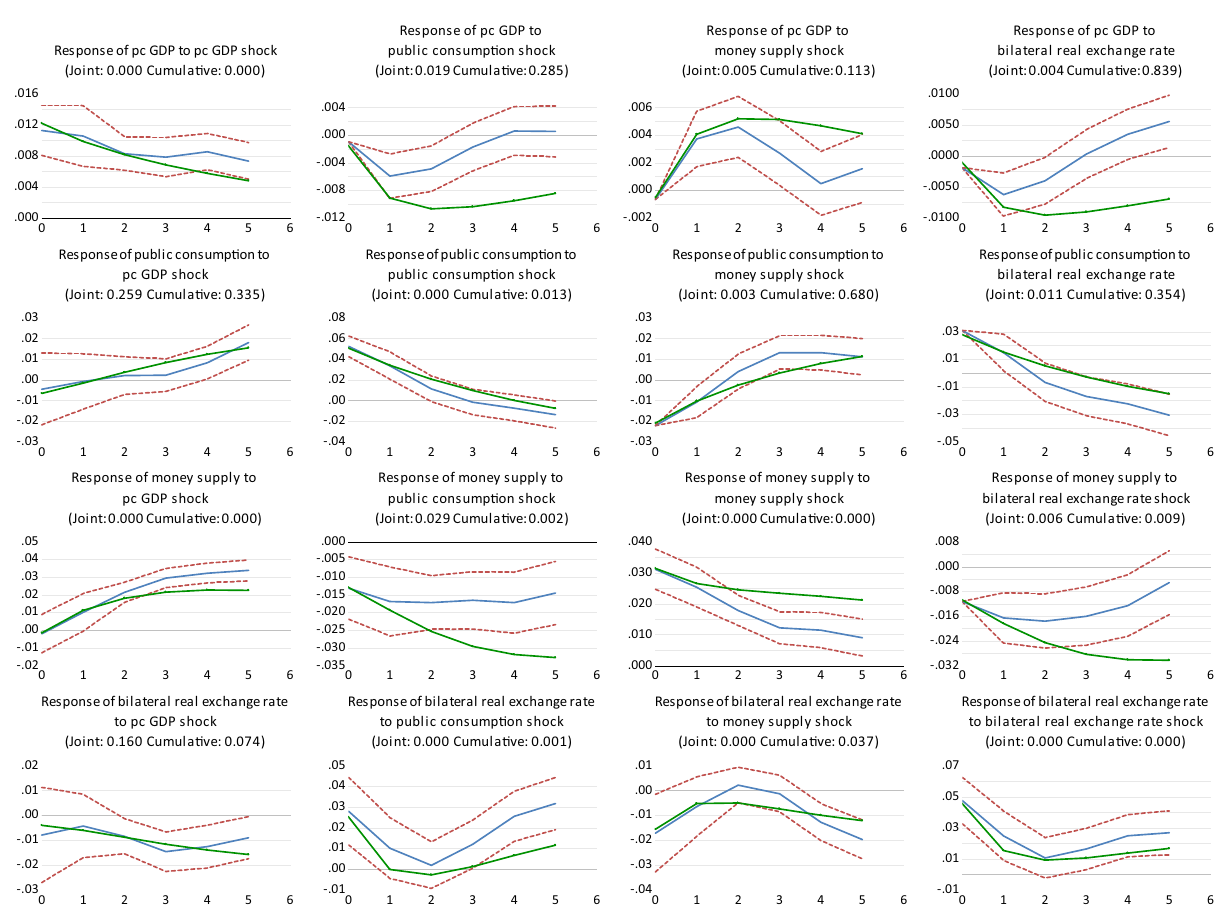
Figure 6: Impulse response function ( Italy )